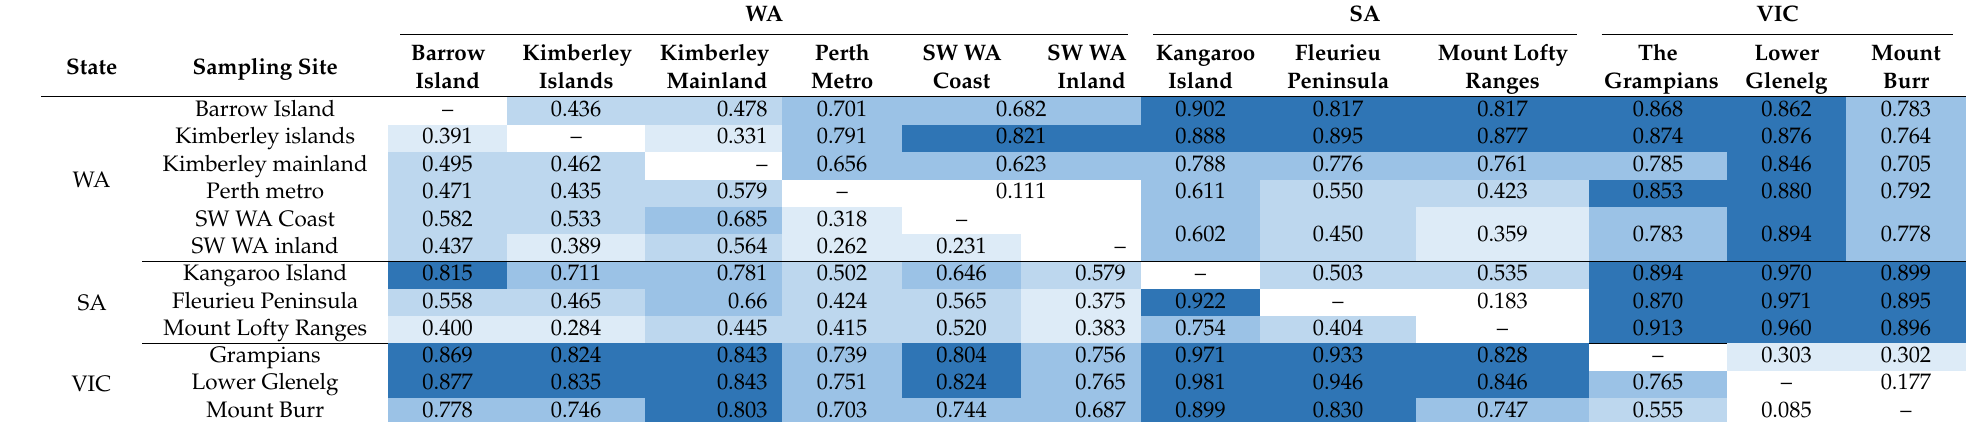
Table 2. Pairwise D est and φ ST values between samples from different locations based on microsatellite (above diagonal) and mtDNA data (below diagonal). WA SA